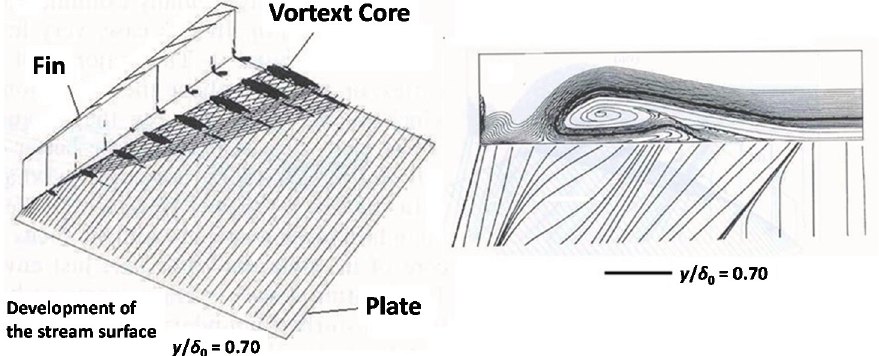
Figure 2. Structure of the separated flow in a swept-shock/turbulent boundary-layer interaction. Flow conditions: M ∞ = 4.0, α = 16°